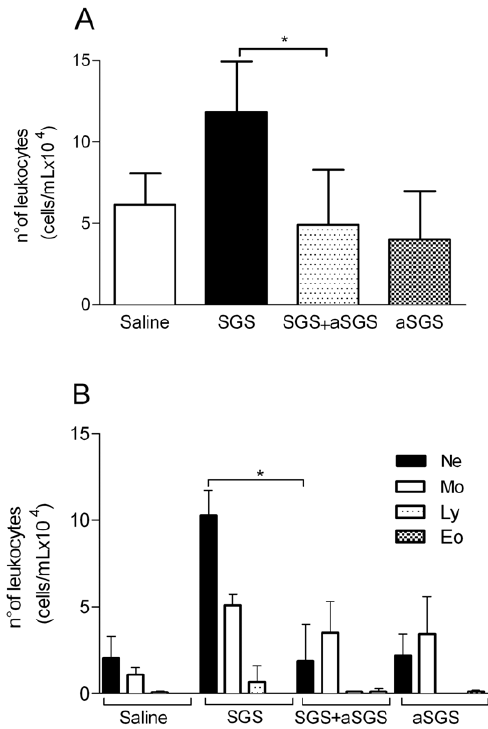
Figure 2. Pre-incubation of L.intermedia saliva with immune serum inhibits leukocyte recruitment. Air pouches were raised on BALB/c mice (five to six per group) and were inoculated with either endotoxin-free saline, L. intermedia SGS, L. intermedia SGS + immune sera (SGS + a -SGS), or immune sera alone ( a -SGS). Exudates were collected twelve hours after initial stimulation. Leukocytes were enumerated microscopically. (A) Total number of leukocytes and (B) total number of neutrophils, monocytes, eosinophils, and lymphocytes accumulated in air pouches. The data shown are from a single experiment represen- tative of three independent experiments. (* P , 0.05; ** P ,